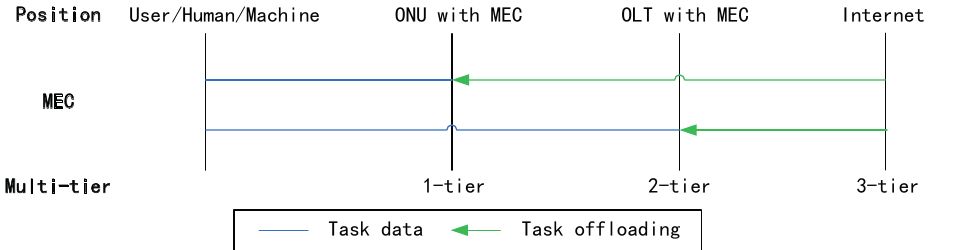
Figure 2. The task and offloading in the FiWi network equipped with three tiers of MEC